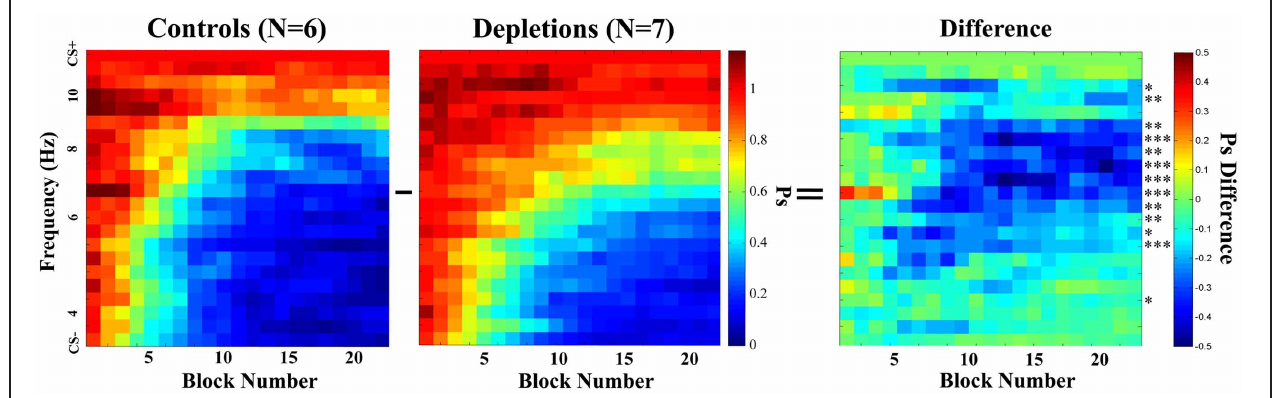
acetylcholine-depleted rats demonstrate poorer discrimination for frequencies that are midway between the CS − and the CS + . This indicates that acetylcholine selective to the visual cortex can facilitate learning to discriminate fine differences in the temporal characteristics of the stimuli. The rightmost graph corresponds to the difference between the two groups; asterisks represent the statistical significance of the differences in the last